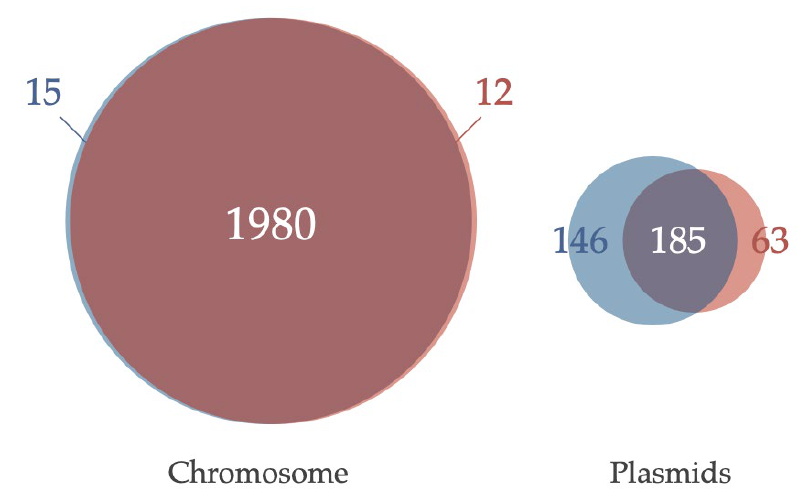
Figure 5. Common and unique genes in the two Acaryochloris strains. Euler diagram showing the common genes between A. marina MBIC10699 (red) and A. marina MBIC11017 (blue) for each chromosome and plasmids, respectively. Genes annotated by KEGG with the same ID were considered common. The numbers indicate the number of genes in the fraction.